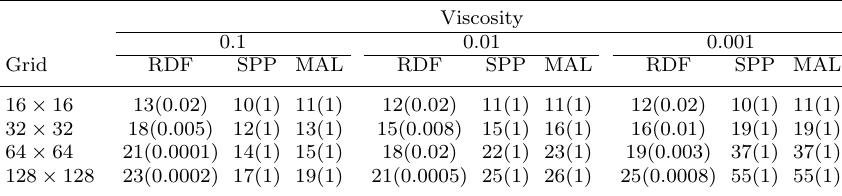
Table 9. Number of GMRES(20) iterations with the RDF, MAL and SPP preconditioners for unsteady Oseen problems (Q2-Q1 FEM stretched grids). The parameter τ is experimen- tally optimal, the parameter α , γ equal 1, the Such complement ˆ S = ( ν + γ ) − 1 W .